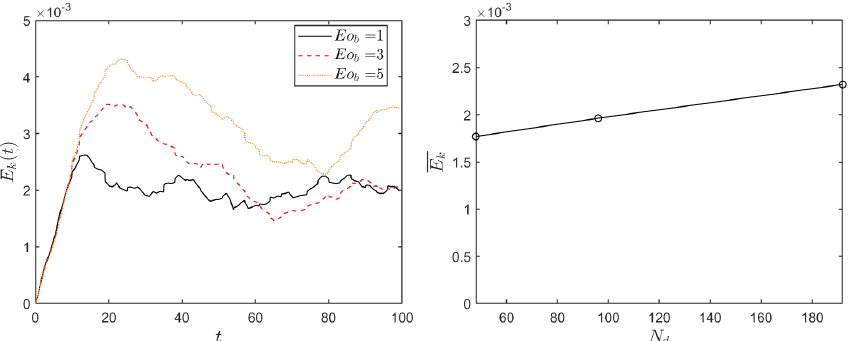
Figure 10. The kinetic energy of the liquid versus time for 96 drops and Eo b = 1.0, 3.0 and 5.0 ( left ) and the time-averaged kinetic energy versus the number of drops for Eo b = 3.0 ( right